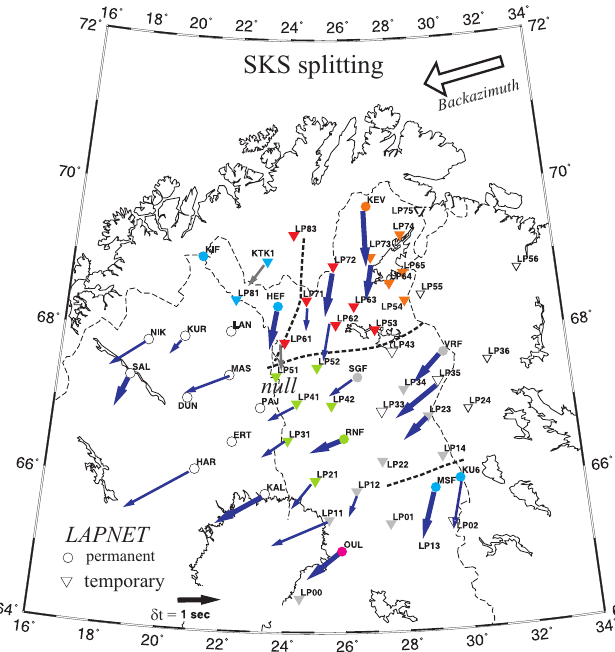
Fig. 3. Geographical variations of fast shear-wave polarizations and split delay times for an event that occurred on 2008/08/04 with epicentre beneath the Banda Sea region. The arrows mark azimuths of fast S-wave polarizations and point in their dip directions in the Q-T planes in the ray parameter co-ordinating system (Vecsey et al., 2008). Stations with similar fast S polarizations and split delay times form groups like those determined from P-spheres (station in the same colours as in Fig. 2). Anisotropic signal of shear wave decreases or disappears (null split) at stations close to domain boundaries (schematically marked by the thick dashed lines). Good, firm and poor splitting measurements are marked by thick, thin and empty-head arrows,